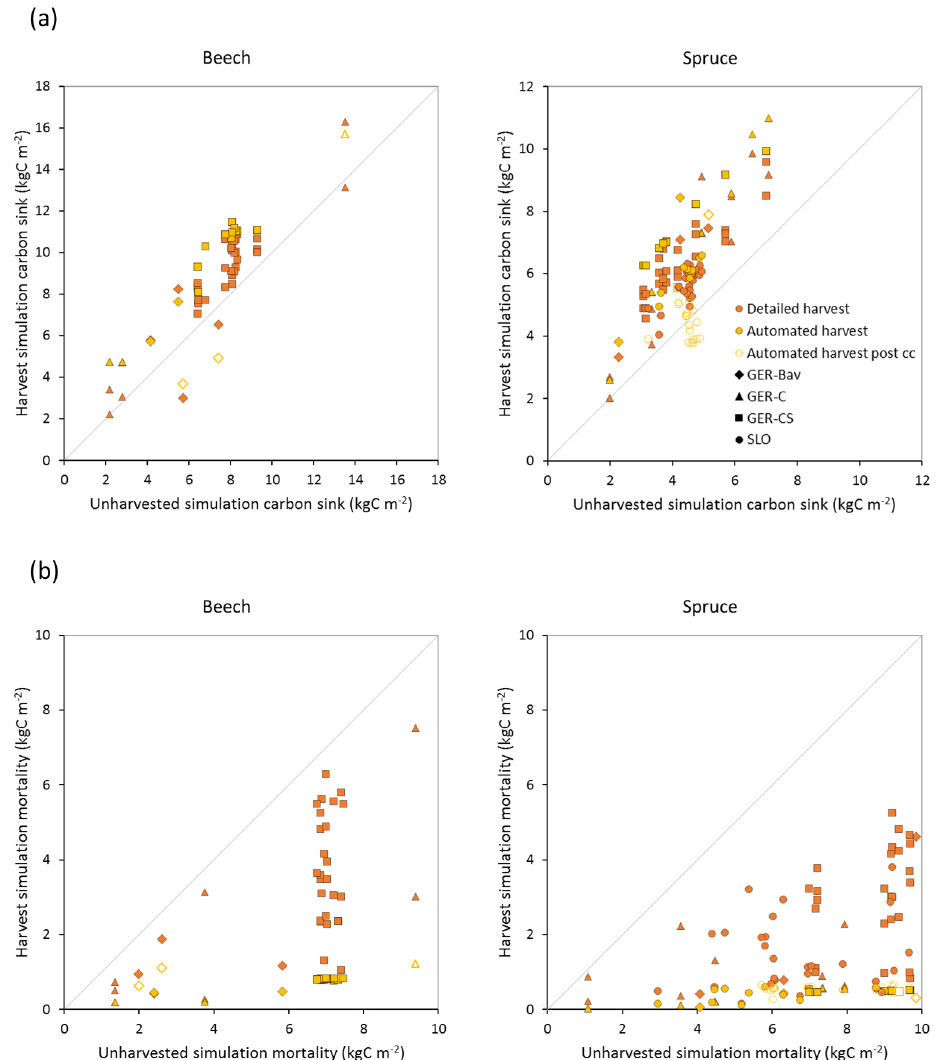
Figure 8. Modelled carbon sink (a) and cumulative mortality (b) for the same time periods as in Fig. 7b in simulations with detailed and automated harvest compared to a simulation without harvest of European beech and Norway spruce stands in Germany (Bavaria: GER-Bav; central Germany: GER-C; central and southern Germany: GER-CS) and Slovenia (SLO). Data points from the automated harvest simulation after clear-cutting occurred are plotted with unfilled symbols (automated harvest post